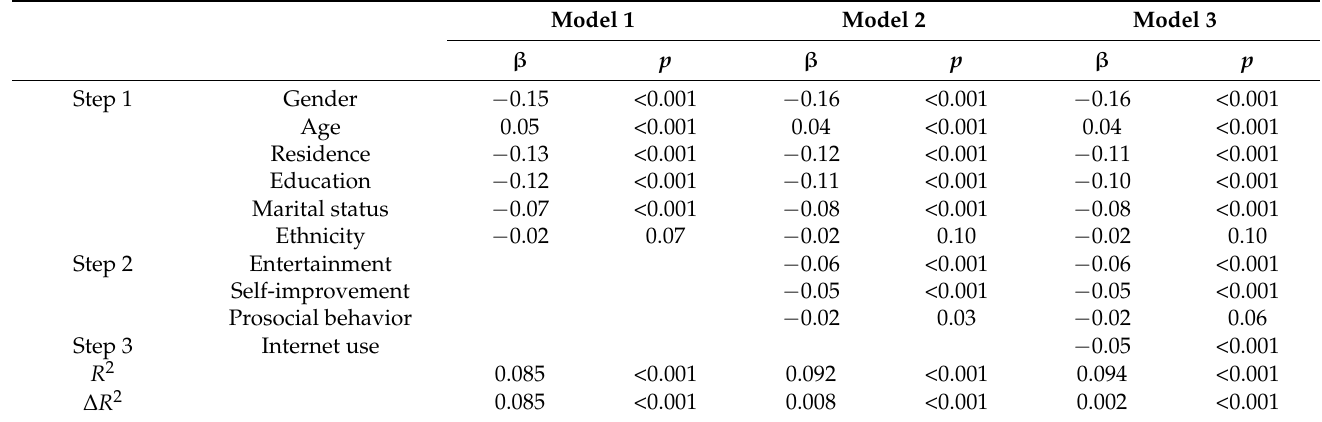
Table 5. Hierarchical regression analysis on depression in Sample 2 (N = 9434).